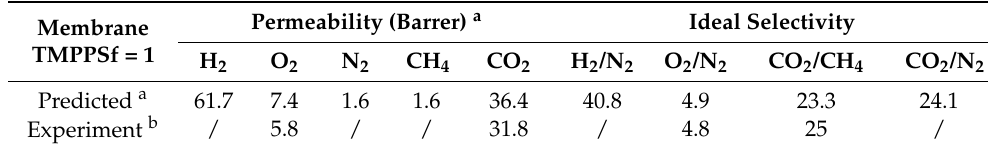
Figure 7. Relationship between permeability coefficient and TMPPSf content. Table 4. Predicted and experiment results (measured at 35 ◦ C under 2 atm) of gas permeability and selectivity when the TMPPSf molar fraction =